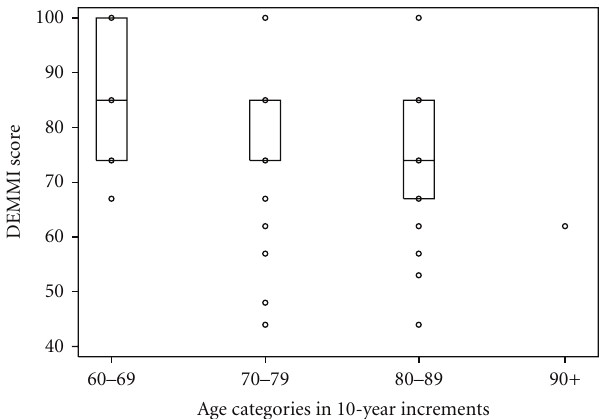
Figure 2: Box plot of DEMMI scores by age category with interquartile ranges (nb in age 70–79, median is the same as the 75th percentile; also, the oldest age category has only one